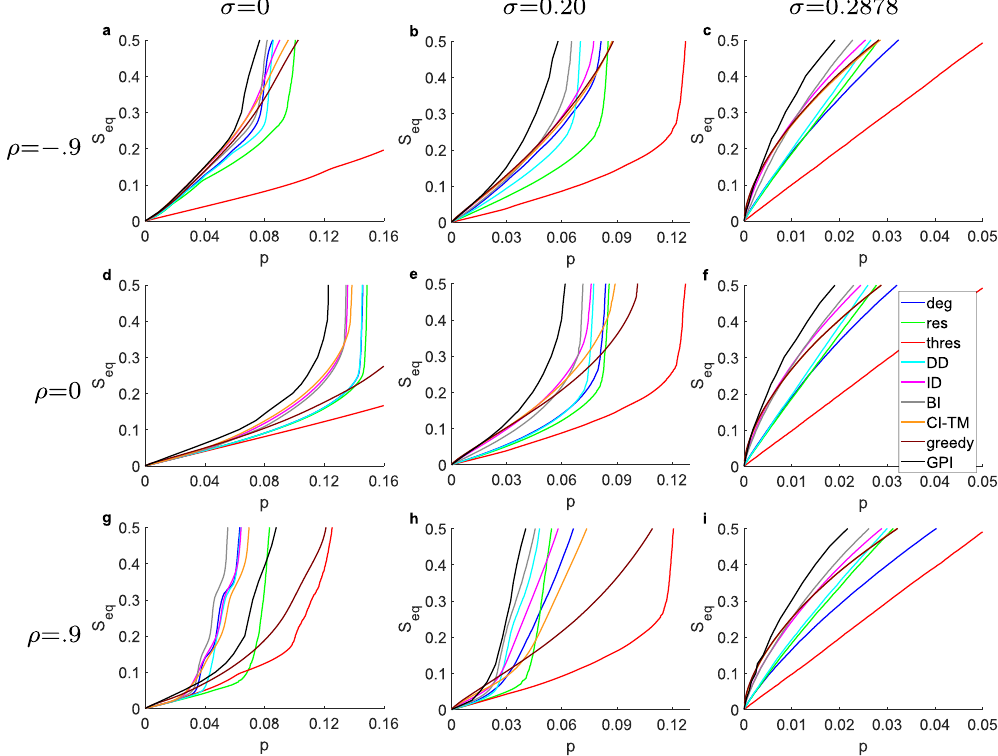
Figure 1. Comparison of the BI and GPI (for different S goal selection strategies in terms of cascade performance S eq for (a – c) ρ = − 0.9, for (d – f) ρ = 0, for (g – i) ρ = 0.9, for (a – g) σ = 0, for (b – h) σ = 0.20, for (c – i) σ =